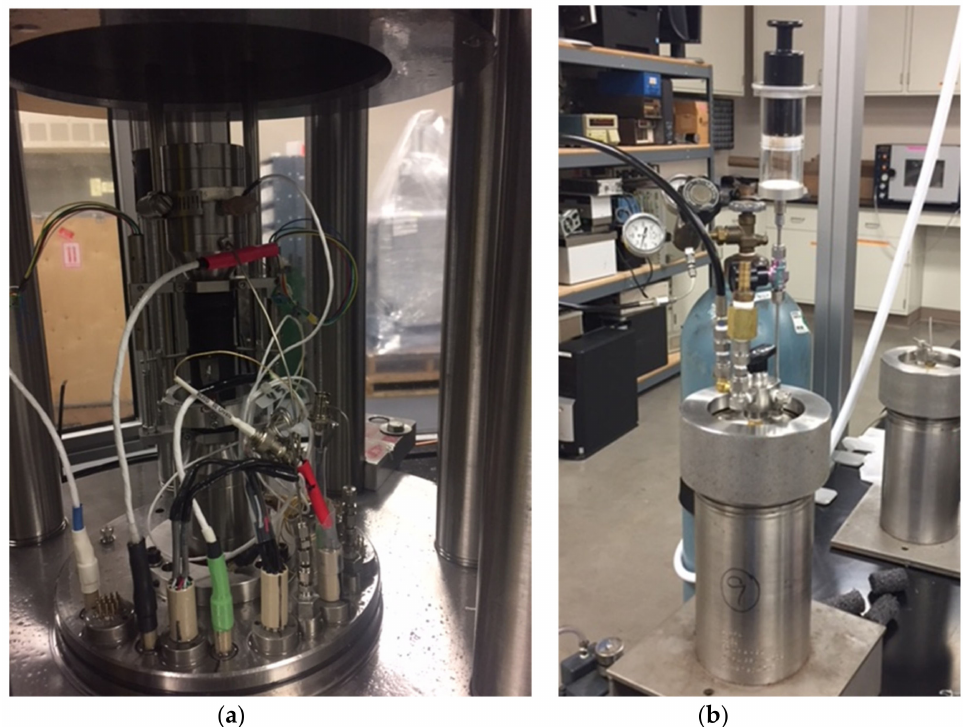
Figure 2. ( a ) Experimental setup for the dry and brine-saturated sample. Internal instrumentation includes load cell to measure deviatoric stress, 2 LVDTs (Linear variable differential transformer) for measurement of axial strain, a radial cantilever bridge, and end caps housing the P and S-wave 1 MHz piezoelectric transducer. (Equipment provided by MetaRock ® laboratories). ( b ) Pressure vessel where sample was saturated; apparatus allows for first vacuum evacuating the sample before saturating with